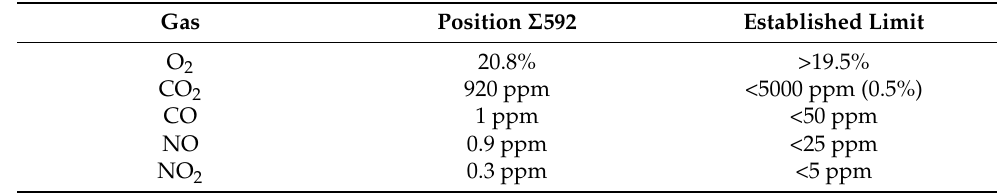
Table 5. Results of gas concentrations at Σ 592 compared to established